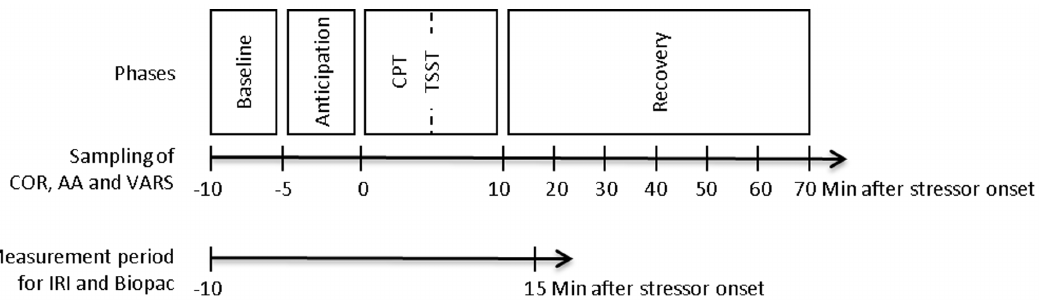
Figure 1. Timeline of the experiment. For the assessment of alpha-amylase (AA) and cortisol (COR), saliva was sampled at discrete measurement timepoints between 2 10 min and 20 min/70 min relative to stressor onset. Visual Analogue Rating Scales (VARS) assessing stress-induced mood changes were administered at baseline ( 2 10 min) and at the end of the anticipation phase/immediately before the onset of acute stress (0 min). The measurement period for the thermal infrared imaging (IRI) and Biopac assessments began at 2 10 min and ended at 15 min relative to stressor